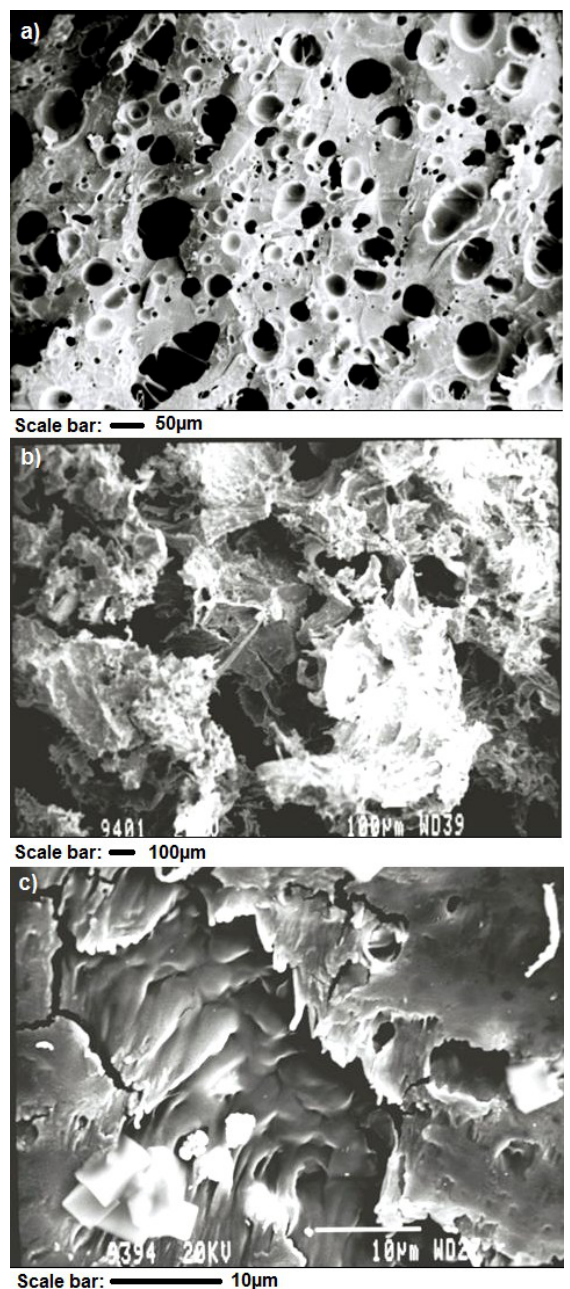
Figure 2. Scanning electron micrographs (Magnification 65×) of compressed: ( a ) PLGA, ( b ) HPMC– PLGA, and ( c ) PEO-PLGA discs following exposure to simulated cerebrospinal fluid (CSF) after 21 days.